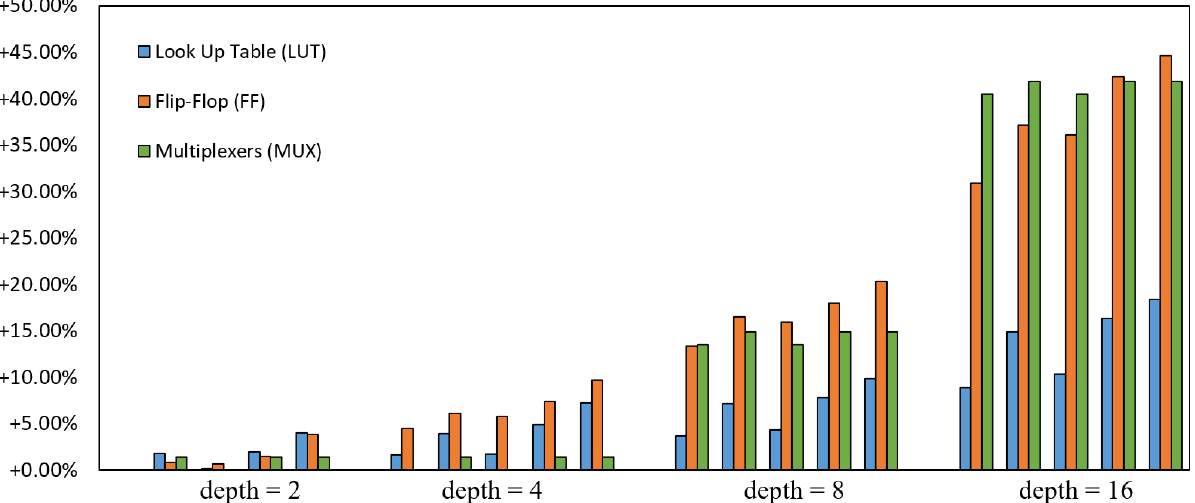
Figure 12. The percentage of increased utilization with different depths of OITF.